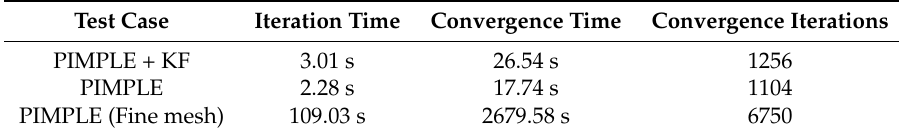
Table 5. Comparison between the run times for the segregated method and the integrated